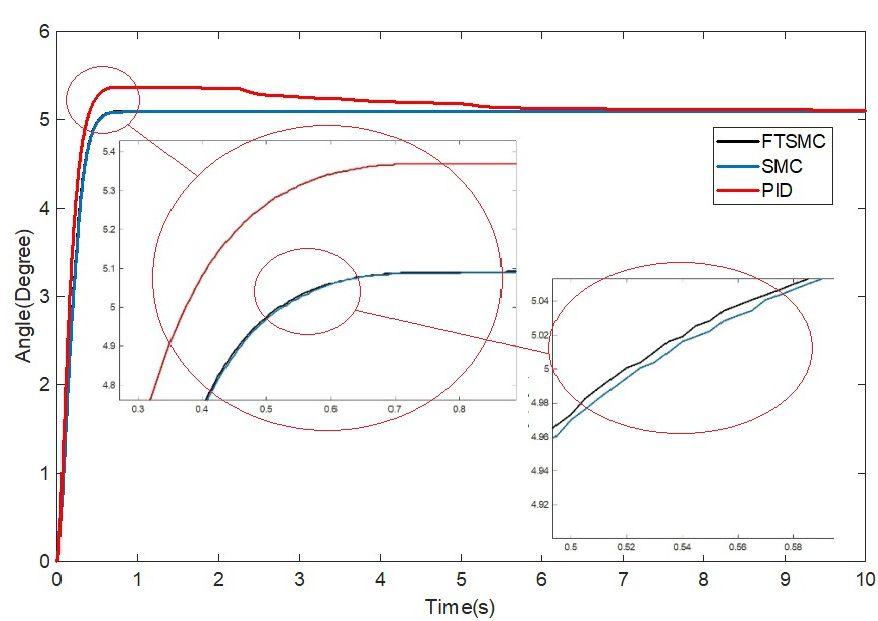
Figure 8. Experiment